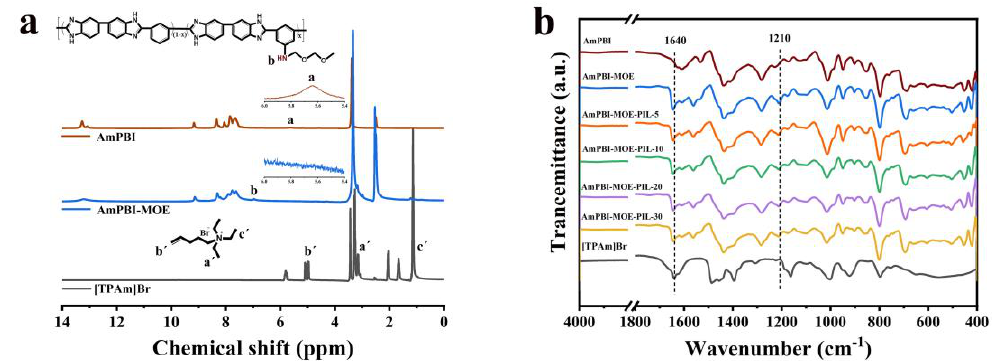
Figure 1. 1 H NMR spectra ( a ) of [TPAm]Br, AmPBI, and AmPBI-MOE; FTIR spectra ( b ) of [TPAm]Br and all the membranes.